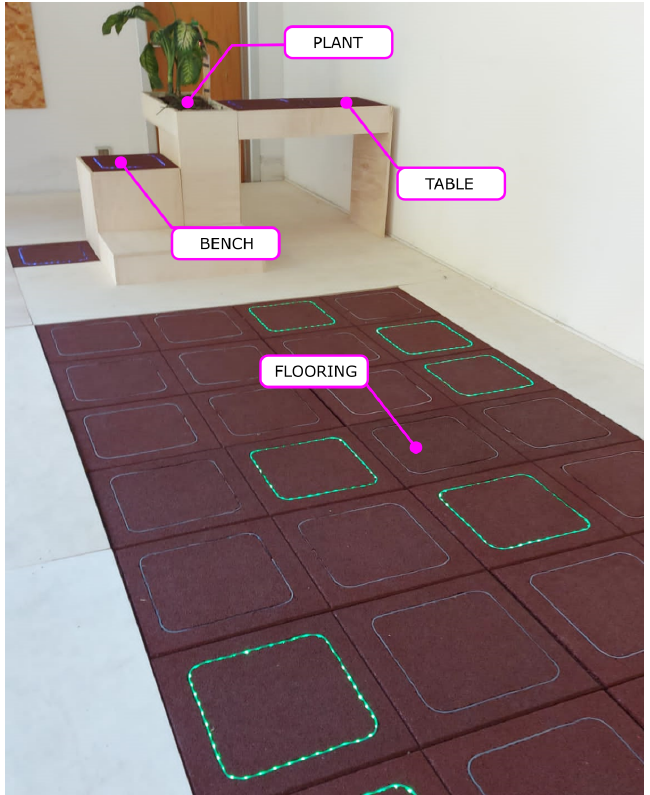
Figure 12. IoT OSOs installed at the “Museo della Civiltà